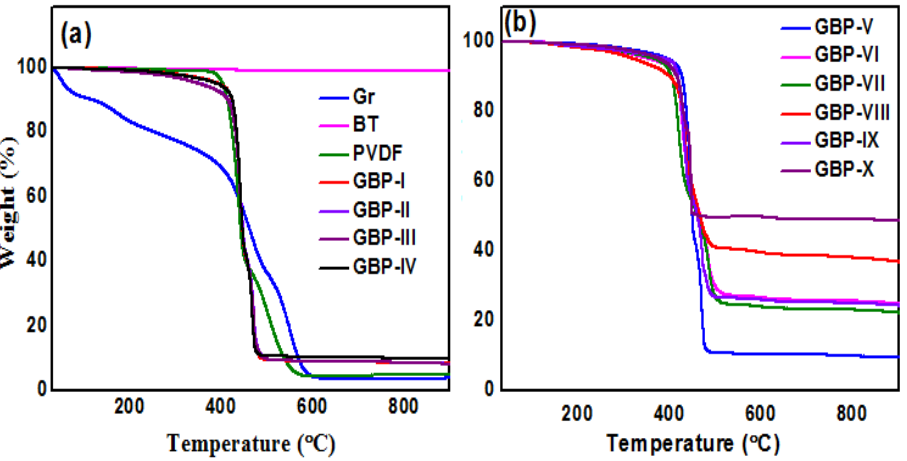
Figure 6. Thermal gravimetric (TG) curves of ( a ) neat PVDF and G/BT/PVDF nanocomposite films with different graphene fraction; ( b ) G/BT/PVDF nanocomposite films with different BT fractions.